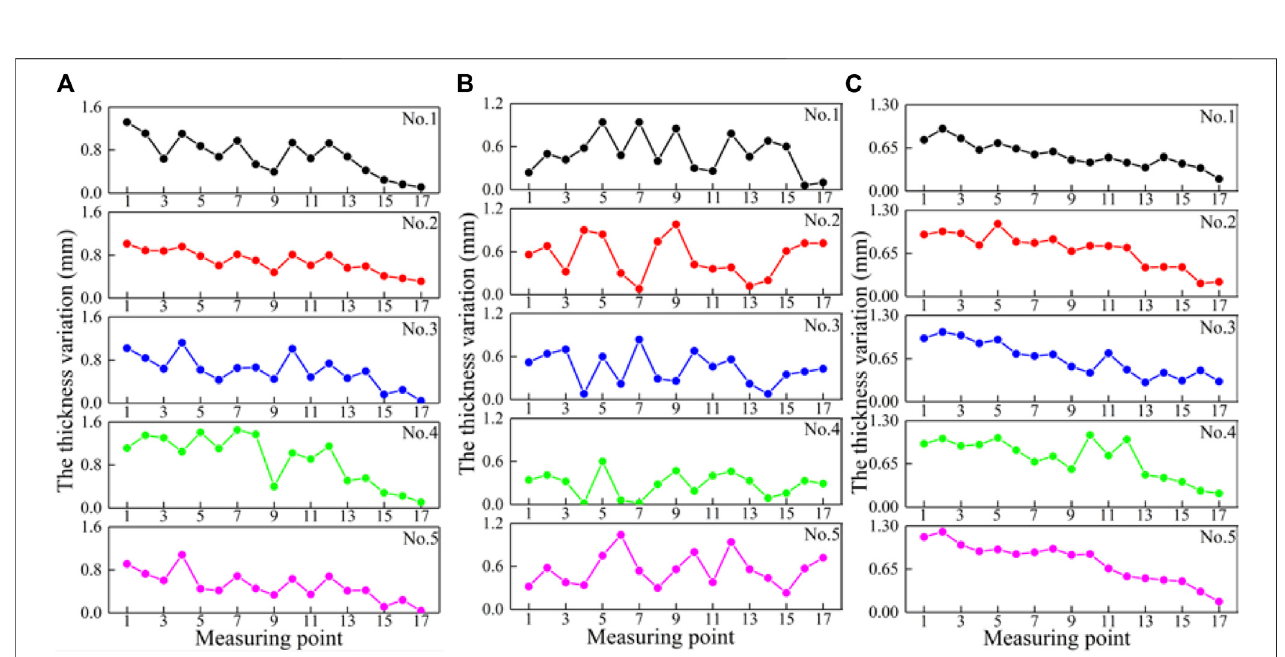
FIGURE 16 | Thickness variation of the blade at measuring points related with different materials (A) 16 Mn, (B) HT200, and (C) Q235.